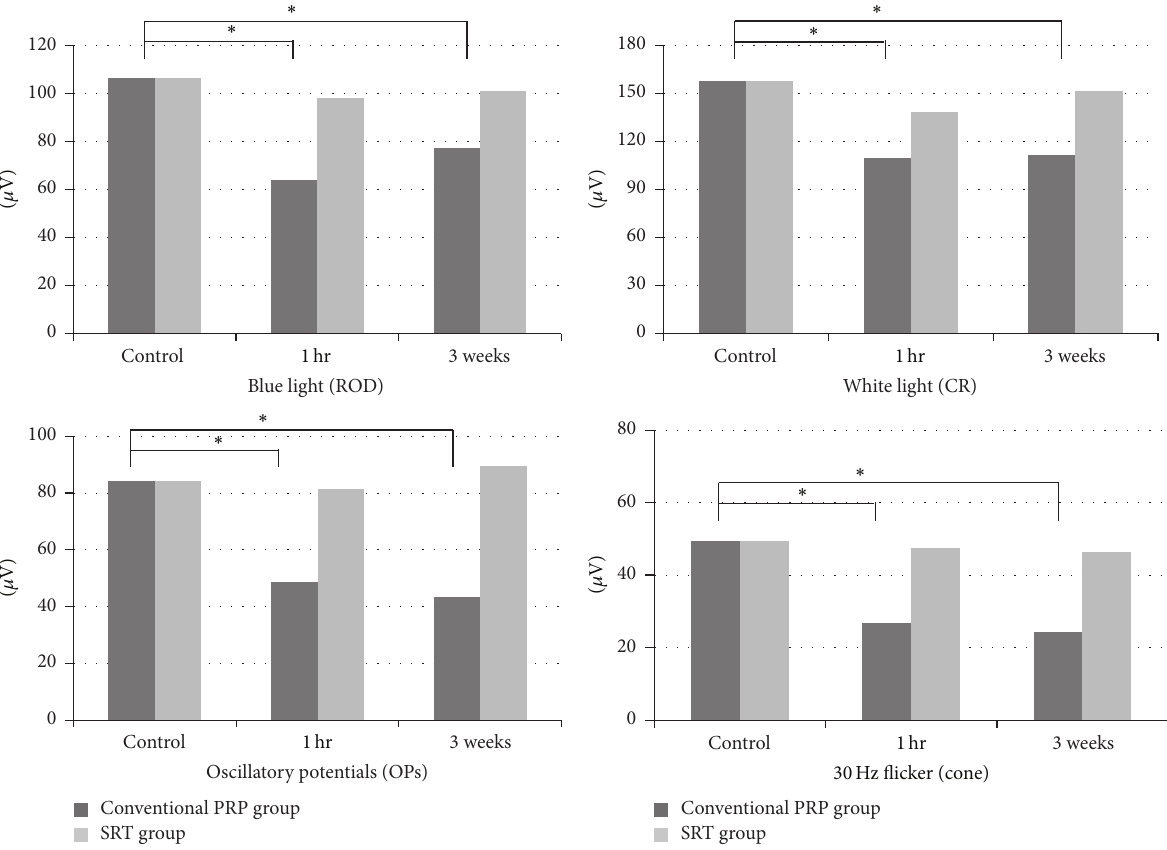
Figure 4: None of the b-wave amplitudes of the rods, CR, the amplitudes of the oscillatory potentials, or the 30-Hz flicker of the SRT group was significantly decreased. However, those of the conventional PRP group were significantly less than the control